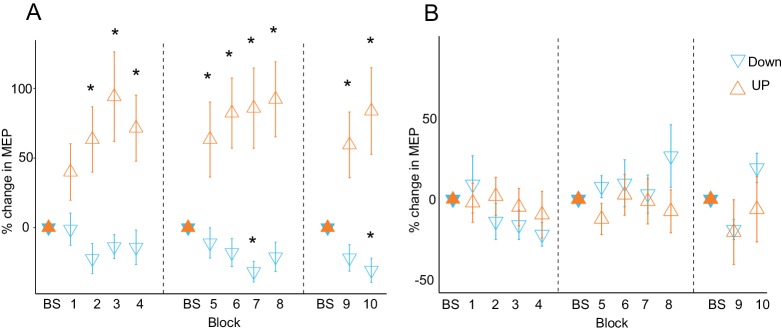
Percentage change in MEP amplitude.Panel (A) shows the % change from baseline at each block for the experimental group (ie. 0 represents no change in MEP amplitude from baseline). Stars indicate blocks in which the % change deviated significantly from 0 (Wilcoxon signed rank test, all p values FDR corrected for multiple comparisons). Panel (B) shows the same data for the control group. During the UP training sessions, MEP amplitudes were increasingly elevated compared to baseline reaching an increase of 83.8% (±31.1 SEM) during the final block of EEG session (block 10). These elevations in MEP amplitude were significantly different from 0 (indicating no change) by the end of 60 neurofeedback trials (block 2), and remained significantly elevated throughout all the remaining blocks (Wilcoxon Signed Rank test, two tailed, all p < 0.03, p values FDR corrected for multiple comparisons). For the DOWN training MEP amplitudes changed less rapidly than in the UP sessions but were reduced by 30.6% (±8.7 SEM) at the end of the final EEG session (block 10). The decreases in MEP amplitude were significantly different from 0 after 210 neurofeedback trials (block 7, Wilcoxon Signed Rank test, two tailed, p = 0.006) and in the final block (10), after 300 training trials (p = 0.016, all p values FDR corrected for multiple comparisons). For the control group shown in panel (B), there were no significant deviations from 0 (no change) in any of the 10 blocks of UP training or DOWN training (Wilcoxon Signed Rank tests, two tailed, all p > 0.11, p values FDR corrected for multiple comparisons).